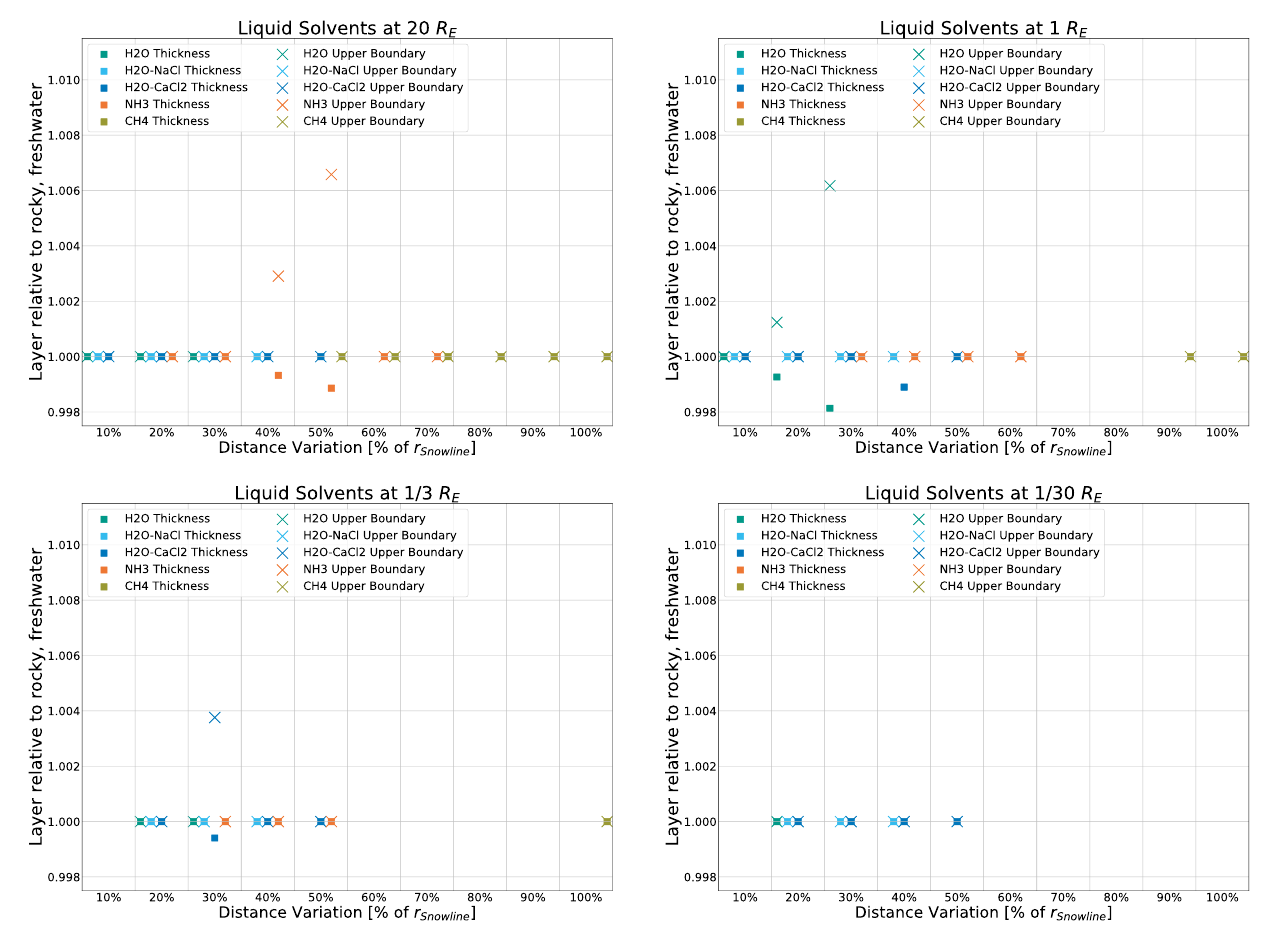
Figure A6. Deviation from the rocky, freshwater model (with a day and night cycle) for a simulation of the rocky, freshwater model with a continuous “day” as if tidally